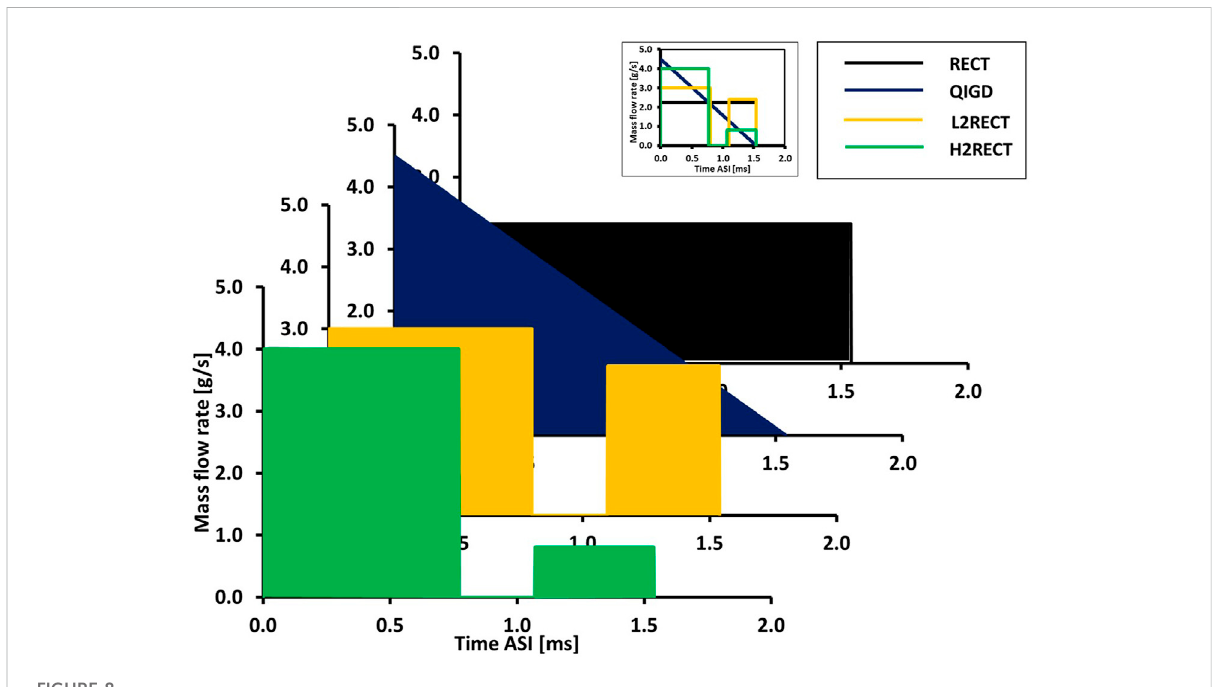
FIGURE 8 Varying injection